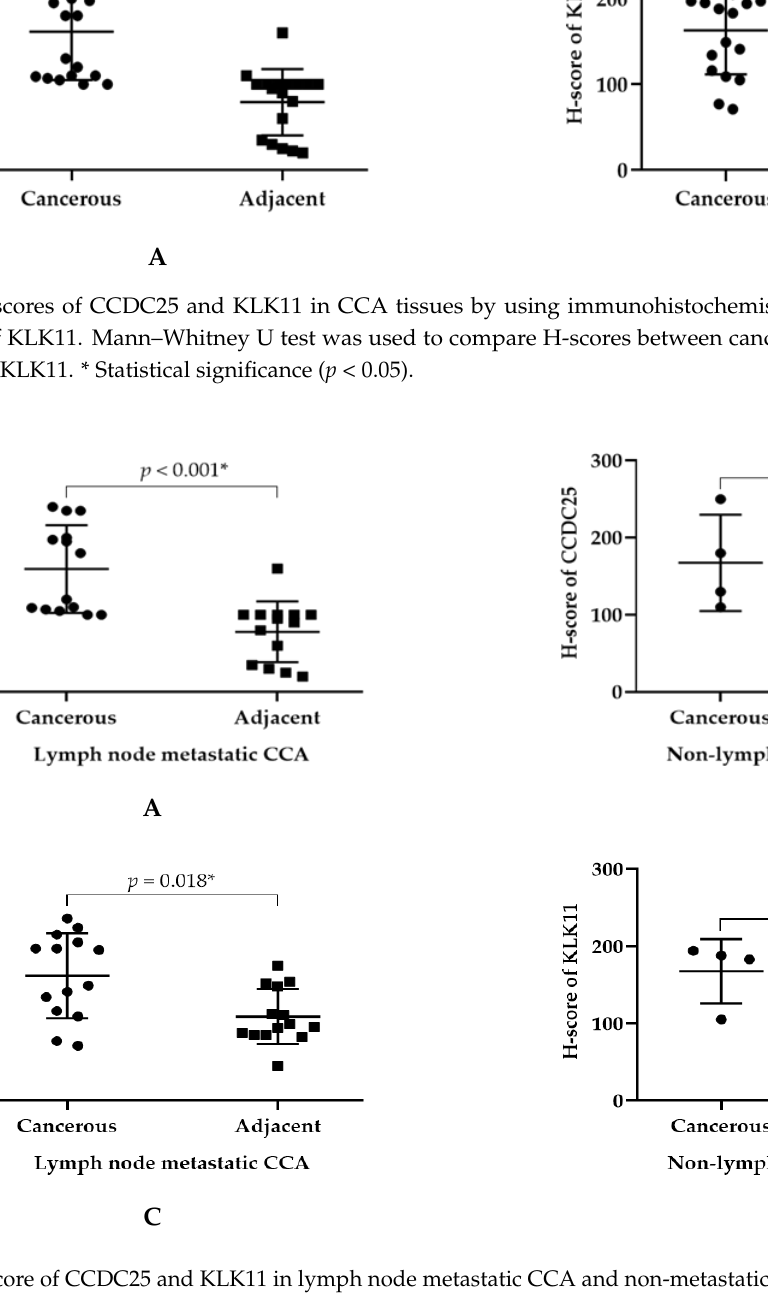
Figure 2. H-scores of CCDC25 and KLK11 in CCA tissues by using immunohistochemistry. ( A ) H-score of CCDC25. ( B ) H-score of KLK11. Mann–Whitney U test was used to compare H-scores between cancerous and adjacent tissues of CCDC25 and KLK11. * Statistical significance ( p < 0.05).